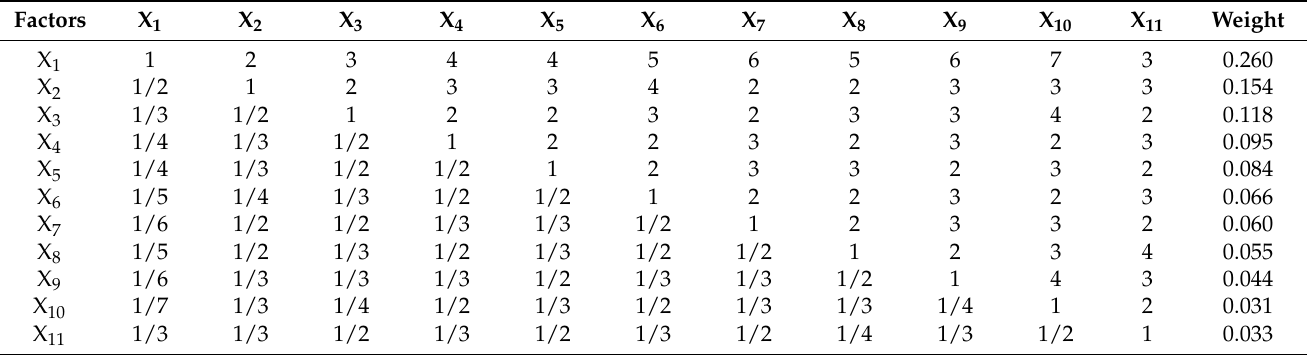
Table 2. Judgment matrix of impact factors.